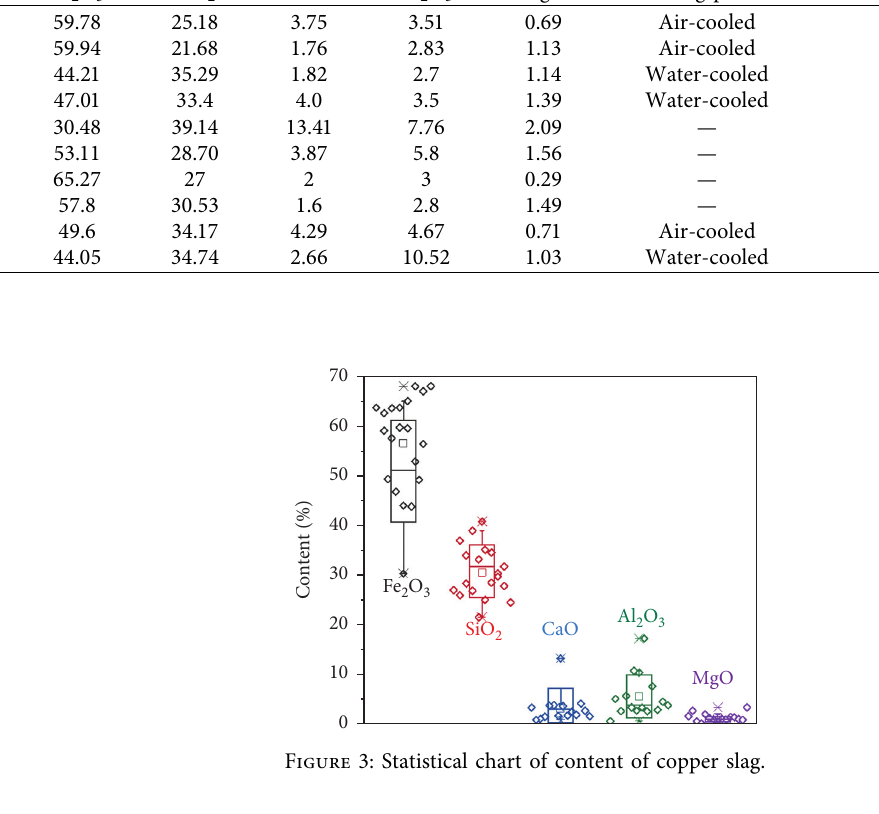
Figure 2: XRD patterns of the copper slag samples. (a) Air-cooled samples. (b) Water-cooled samples [67]. Table 1: Chemical composition of copper slag (M � magnetite, F � fayalite, H � hematite, D: diopside, C: clinoferrosilite). Material